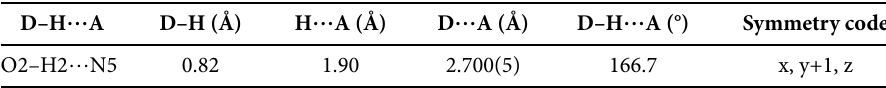
Table 6. Hydrogen bonding geometry for compound 12d · 2CDCl 3